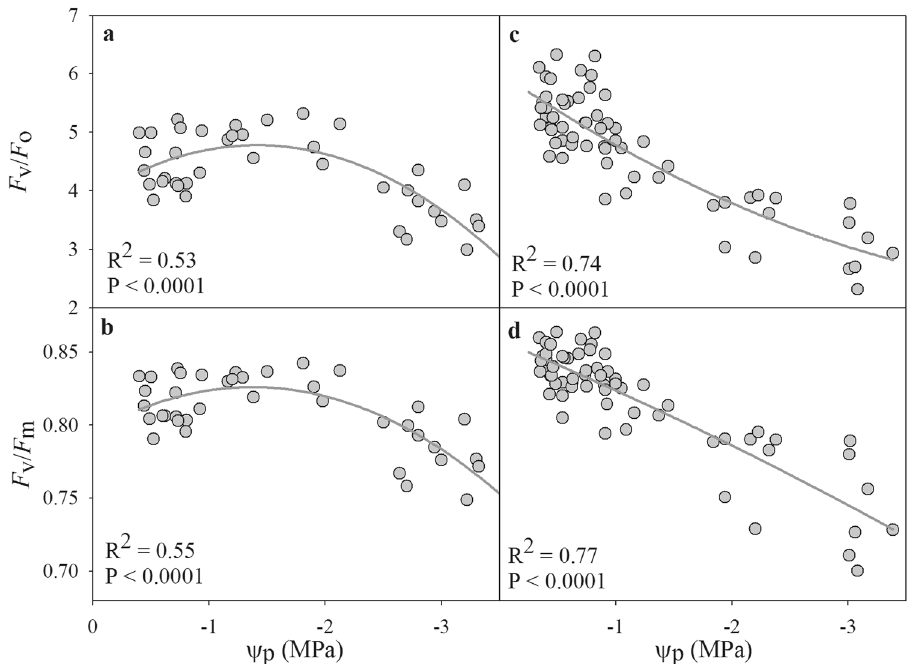
Figure 5. Relationship between the ratio of variable fluorescence to original fluorescence ( F v / F o ) and maximal quantum yield of PS II ( F v / F m ) and the Ψ p during drought in A. fruticosa ( a and b ) and R. pseudoacacia ( c and d ). The data used in the figure are pooled over both drought